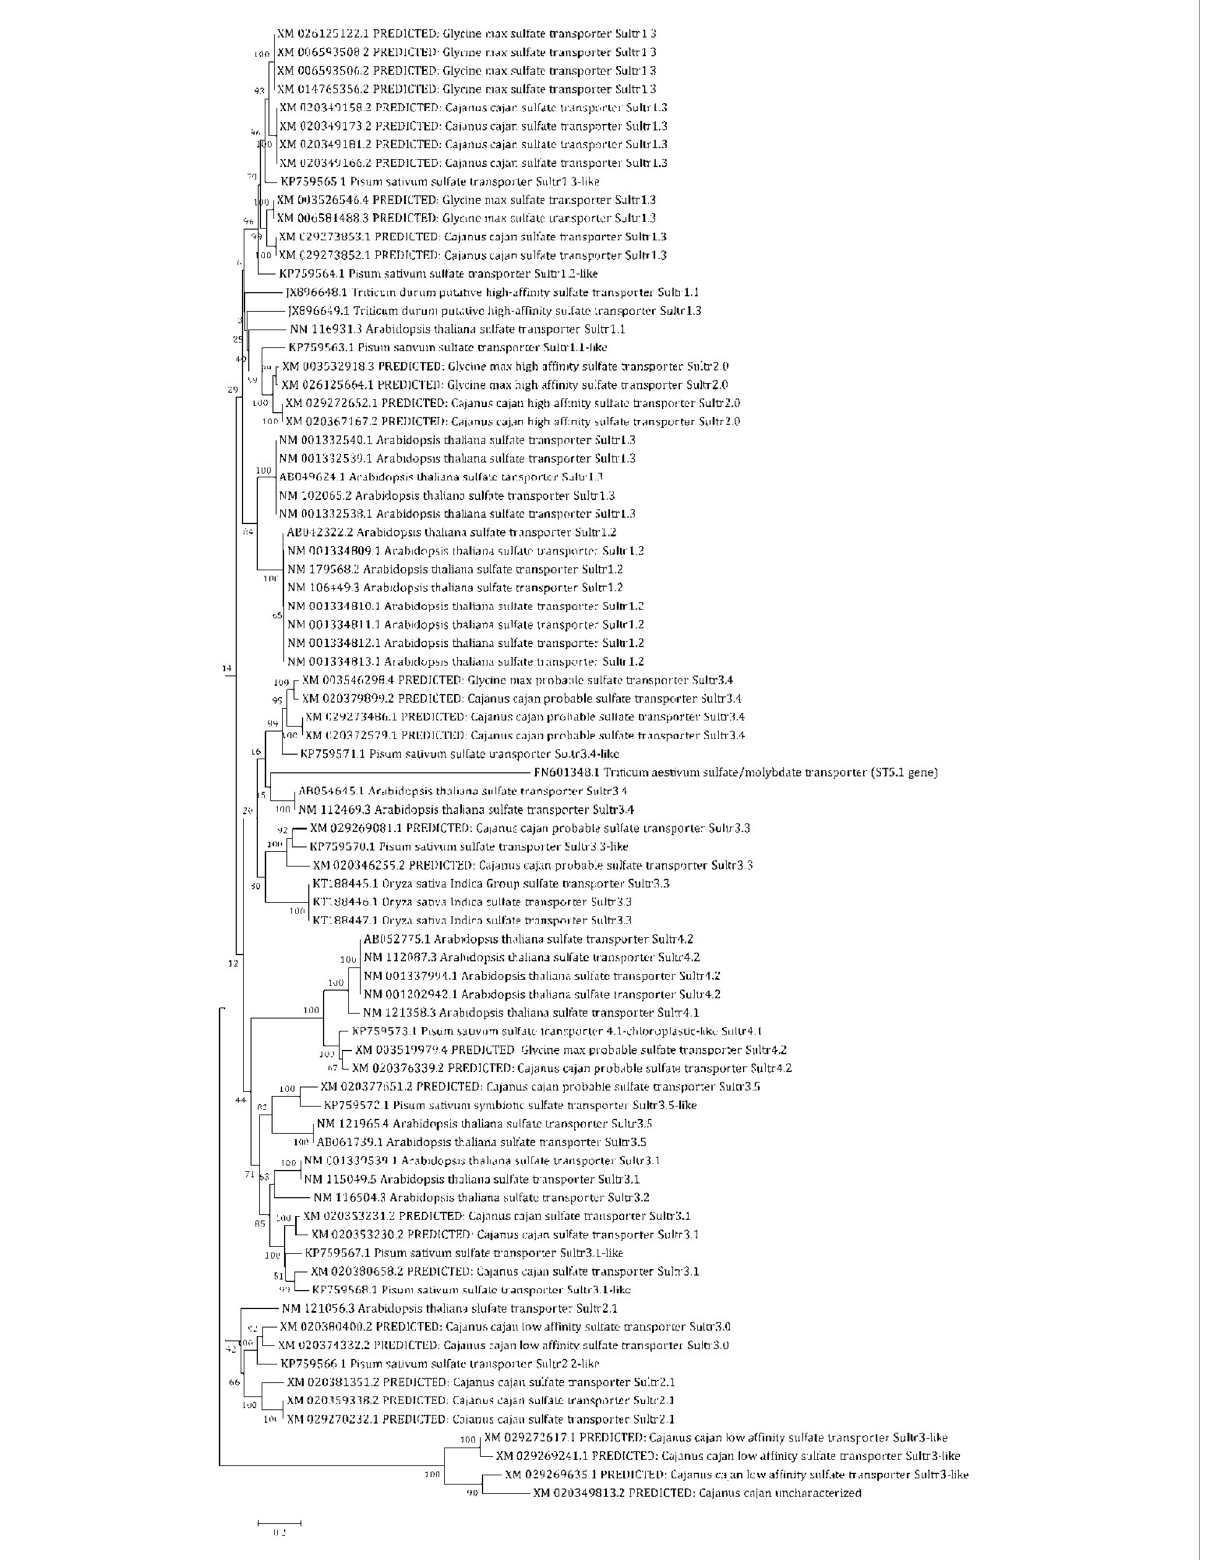
FIGURE4 Phylogenetic tree showing the relationships of SULTR domains of pigeonpea, with other crop plants, Arabidopsis, soybean, field pea, rice, and wheat and classified into different groups.